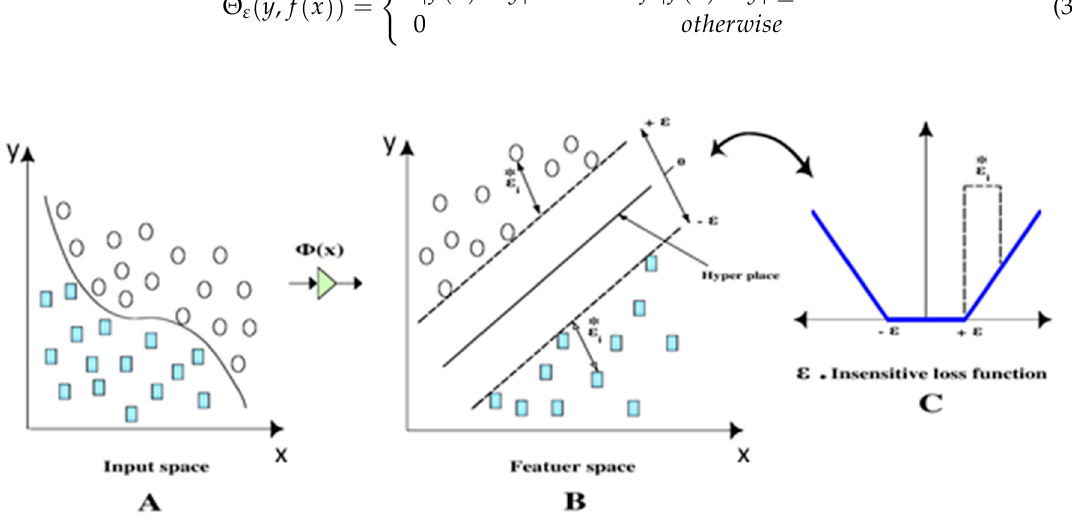
Figure 2. ( A ) Initial Space. ( B ) Feature space. ( C ) Insensitive error function.